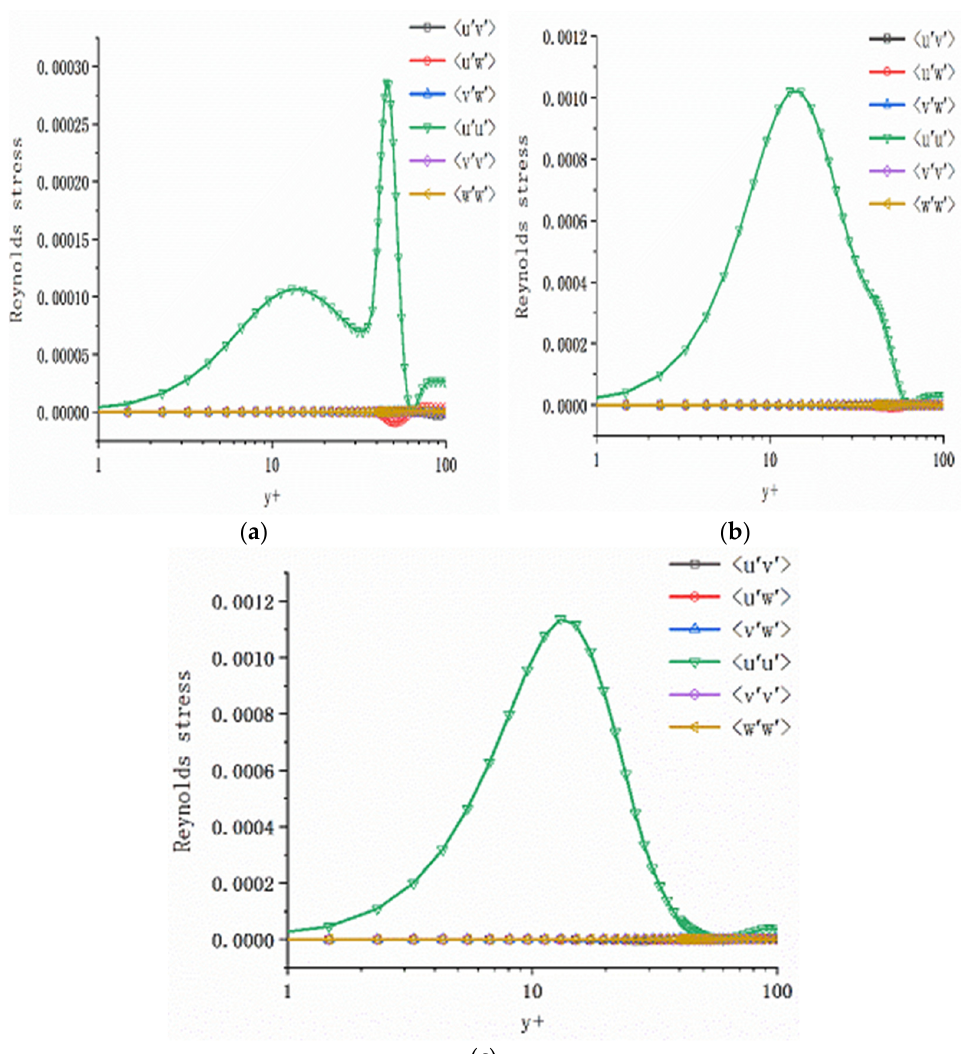
Figure 25. Distribution of Reynolds stress in rectangular groove along the normal direction of the plate at 0.3Ma; ( a ) Z = 0.00044625 m; ( b ) Z = 0.00047 m; and ( c ) Z = 0.0005 m.